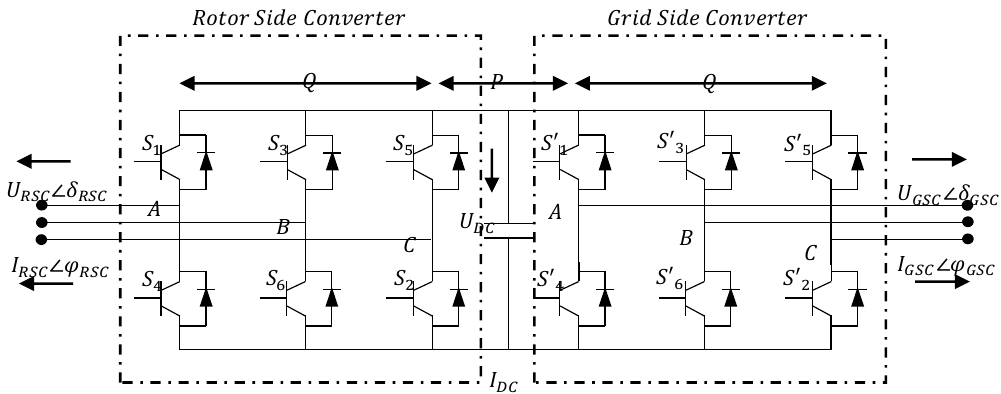
Figure 6. B2B power converter configuration.